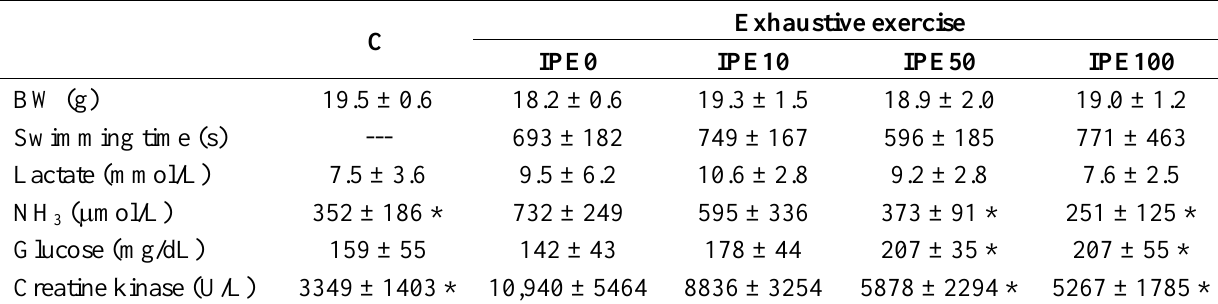
Table 1. Effect of I. parviflora extract (IPE) supplementation on body weight